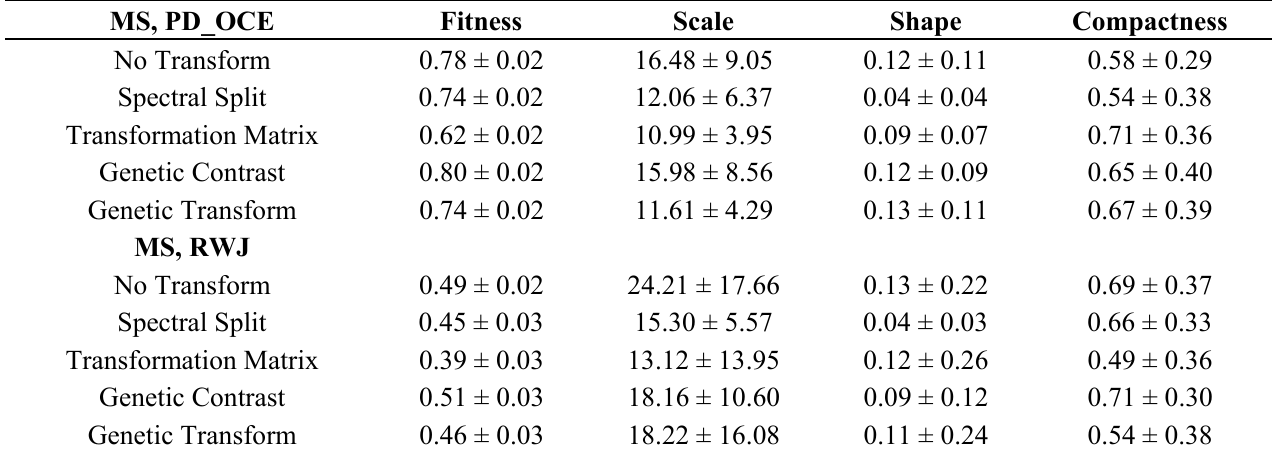
Table 6. Multiresolution Segmentation (MS) segmentation algorithm parameters obtained over different metric and data transformation function conditions for the Hagadera test site.